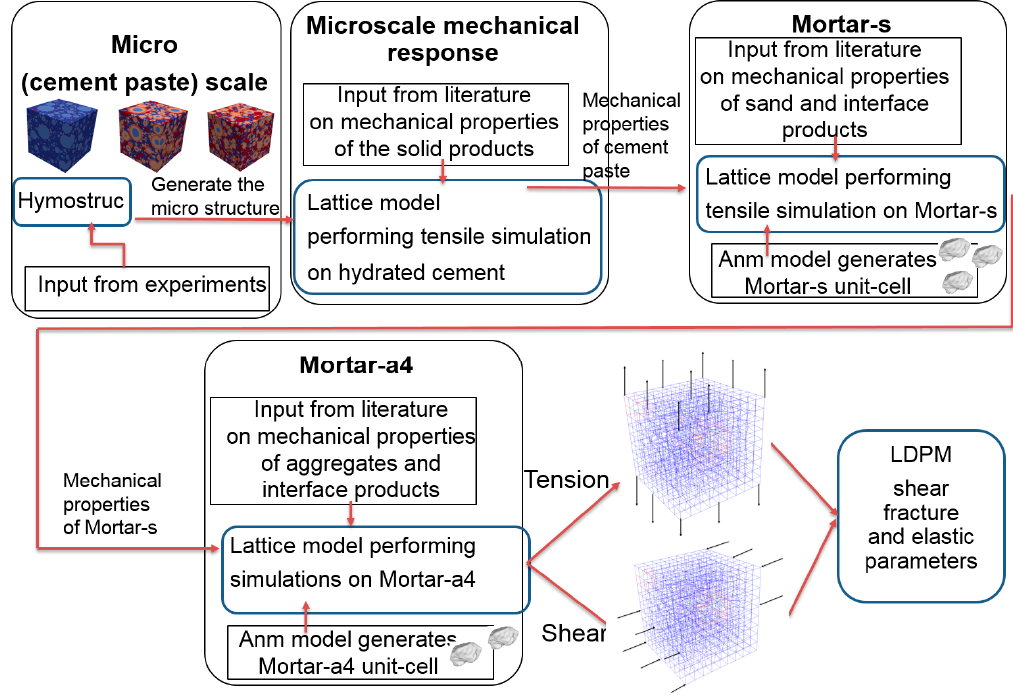
Figure 3. Flowchart of the suggested upscaling procedure.